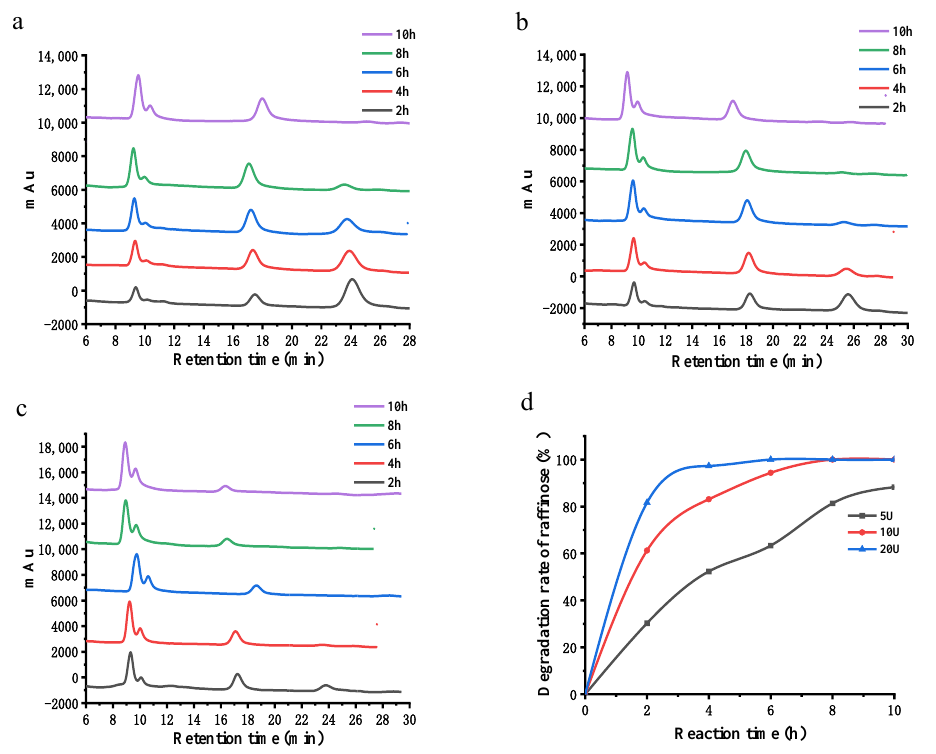
Figure 9. Analysis of the hydrolysis of raffinose by HPLC. ( a ) Enzyme dosage was 5 U/mL; ( b ) en- zyme dosage was 10 U/mL; ( c ) enzyme dosage was 20 U/mL. ( d ) The degradation rate of raffinose.